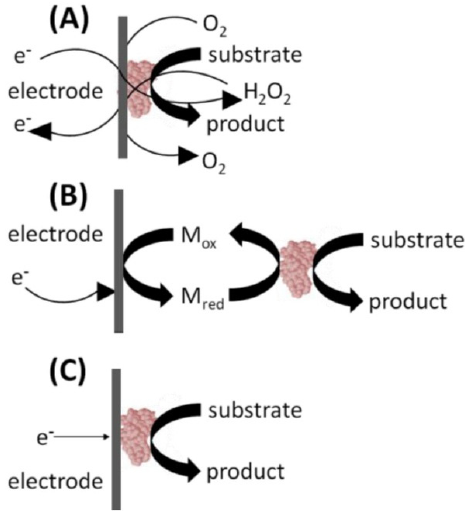
Figure 3. The three generations of biosensors showing transition from: ( a ) enzyme dependency to ( b ) mediator use and ( c ) finally to the use of a catalytic electrode.